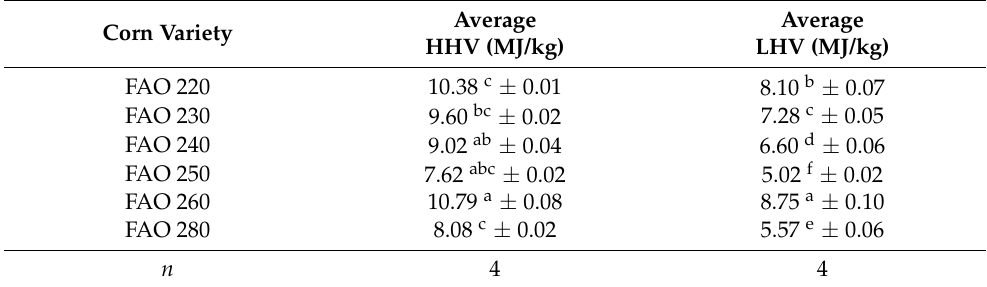
Table 5. Heat of combustion and calorific value of corn cob cores after harvest depending on the FAO